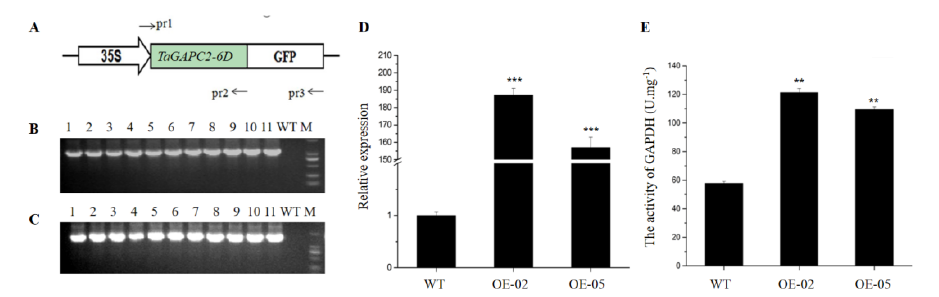
Figure 4. Detection of transgenic plants. ( A ) Diagram of the 35S:TaGAPC2-6D constructs. TaGApC2-6D CDS was fused with the GFP-coding region driven by a 35S promoter. The primers pr1, pr2, and pr3, used to analyze TaGApC2-6D and TaGApCs-GFp in transgenic Arabidopsis plants, are shown. ( B ) PCR analysis of TaGApC2-6D over-expressing transgenic Arabidopsis using primer pairs of pr1 and pr2. ( C ) PCR analysis of TaGApC2-6D over-expressing transgenic Arabidopsis using primer pairs of pr1 and pr3. ( D ) Quantitative real-time PCR (qRT-PCR) validation of TaGApC2-6D in the aboveground part of the three-week-old Arabidopsis plant. The AtTubulin gene was used as an internal reference (*** p < 0.001). ( E ) The enzyme activities of glyceraldehyde-3-P dehydrogenase (GAPDH) in the aboveground part of the three-week-old Arabidopsis plant (** p < 0.01).